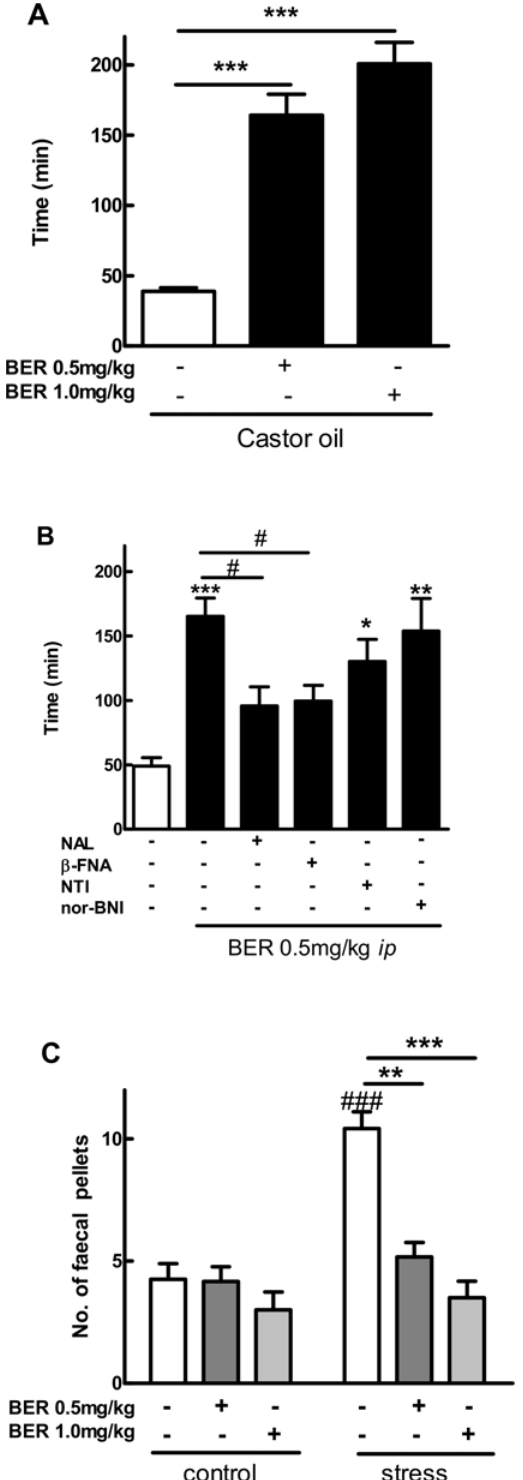
Fig 2. Effect of berberine (BER) on diarrhea and gastrointestinal hypermotility in mice. Data are mean ± SE ( n = 6 – 10). A: I . p . berberine (0.5 and 1 mg/kg) prolonged time to diarrhea in the mouse model induced by oral administration of castor oil. *** P < 0.001, vs . control. B: I . p . opioid antagonists: naloxone (NAL, 1 mg/kg) and β -funaltrexamine ( β -FNA,1 mg/kg), but not naltrindole (NTI, 1 mg/kg) or